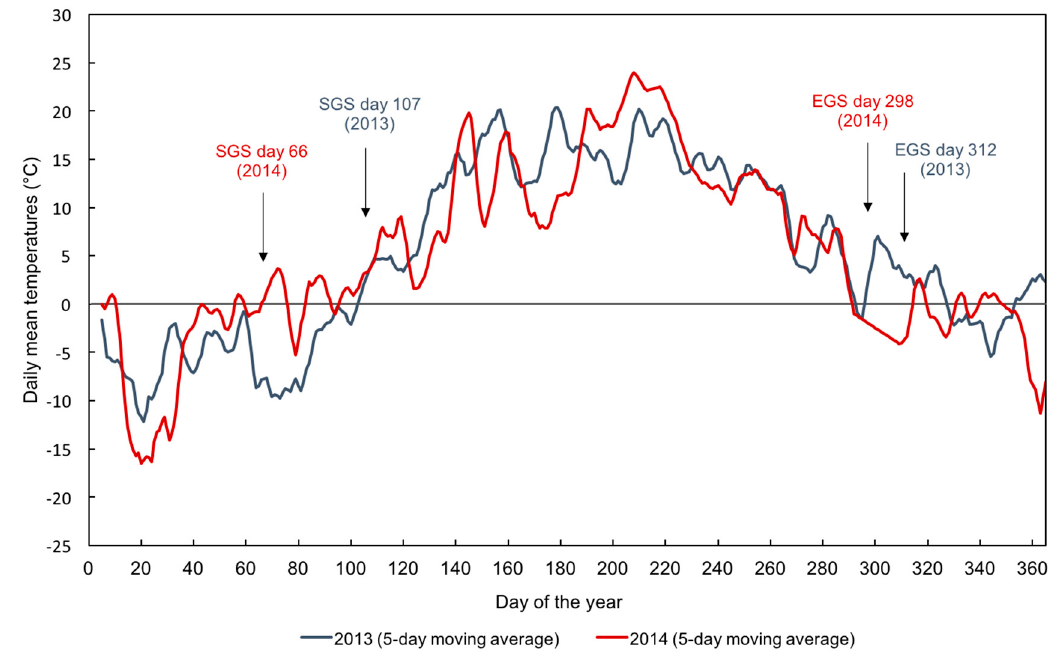
Figure 5. Daily mean air temperature measurements (five-day moving averages) at the Hyytiälä Forestry Field Station for 2013–2014. The start of the growing season (SGS) dates predicted from the NEE data occur almost immediately after air temperatures exceed 2–3 °C.